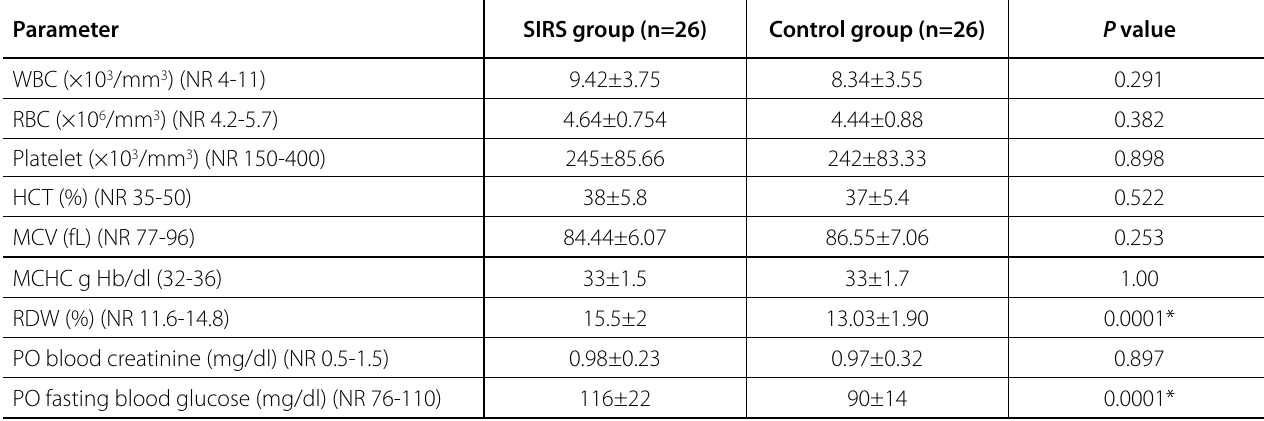
Table 3. Laboratory parameters.